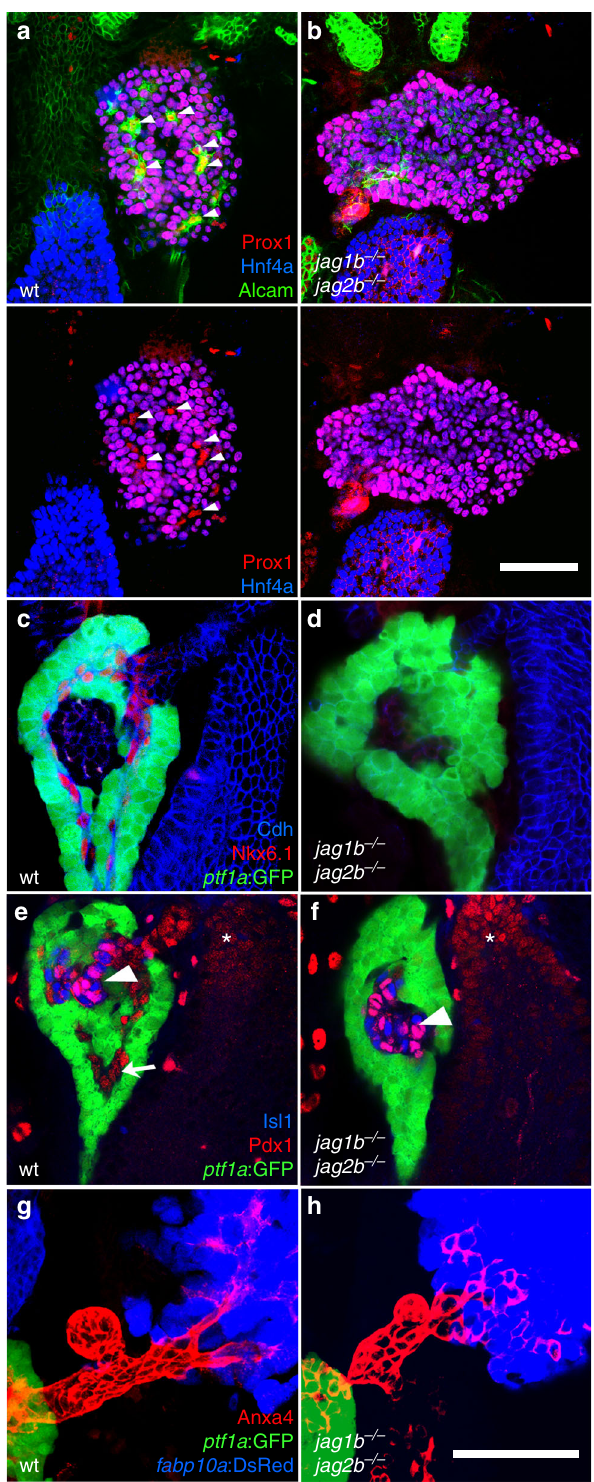
Fig. 2 Jag1b and Jag2b are required for intrahepatopancreatic duct lineage speci fi cation. a – h Whole organ immuno fl uorescence expression analysis of the 72 hpf foregut endoderm of wild type and jag1b − / − ;jag2b − / − mutant embryos. ( a , b Alcam channel removed in bottom panels ). Intrahepatic duct cells marked by high Alcama levels ( a , green ), and by Prox1 ( red ) but not Hnf4a expression ( blue , a ), are found in wild type liver ( arrowheads , a ). These duct cells are not found in the jag1b − / − ;jag2b − / − mutant liver ( b , representative sample, n = 13), which is comprised entirely of hepatocytes expressing both Prox1 and Hnf4a. c – f Intrapancreatic ductal cells expressing Nkx6.1 ( red , c , d ) or Pdx1 ( red , arrow , e , f ) are present in wild type but not in jag1b − / − ;jag2b − / − mutants. Pdx1 expression in Islet1 + cells ( blue , arrowheads ) and the duodenum ( asterisk ) is comparable to wild- type siblings, as is expression of ptf1a :GFP + ( green ) acinar cells c – f and Anxa4 + ( red ) extrahepatopancreatic duct cells ( red , g , h ). g , h Anxa4 + ( red ) extrahepatopancreatic ducts can be found joining the ptf1a :GFP + ( green ) pancreatic acinar cells to the fabp10a :DsRed + hepatocytes ( blue ). Representative samples from three different jag1b − / + ;jag2b − / +